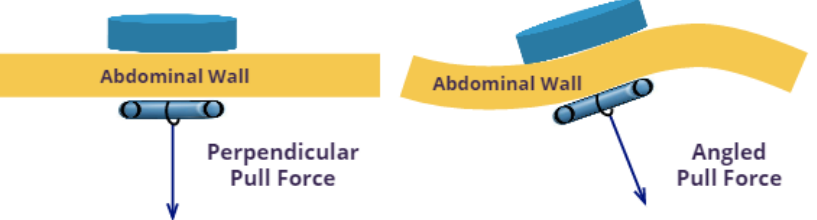
Figure 17. Self-aligning by providing a limited range of freedom in the pitch and yaw joints. Giving some angle constraint to the connecting features, instead of allowing full ranges of rotation, was carried out, mainly to prevent the rod magnets from colliding with each other or moving too close to each other where the magnetic forces between them would jeopardize the structural integrity of the device, leading to elevated stresses, and potentially even resulting in structural